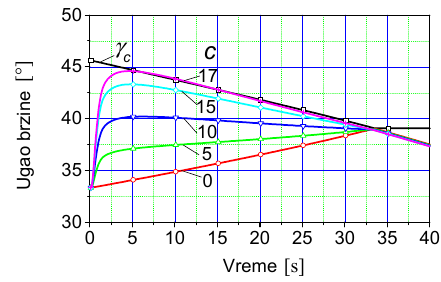
i ugao propinjanja (cid:70) teže ka istoj vrednosti, koja je jednaka uglu korelisa- , što zna č i da se prekid rada ne brzine c raketnog motora odvija pri nultom na- = 0). Ovakav režim le- padnom uglu ( co ta povoljan je za balisti č ke rakete, jer fa- za nevo đ enog ili slobodnog leta po č inje minimalnim poreme ć